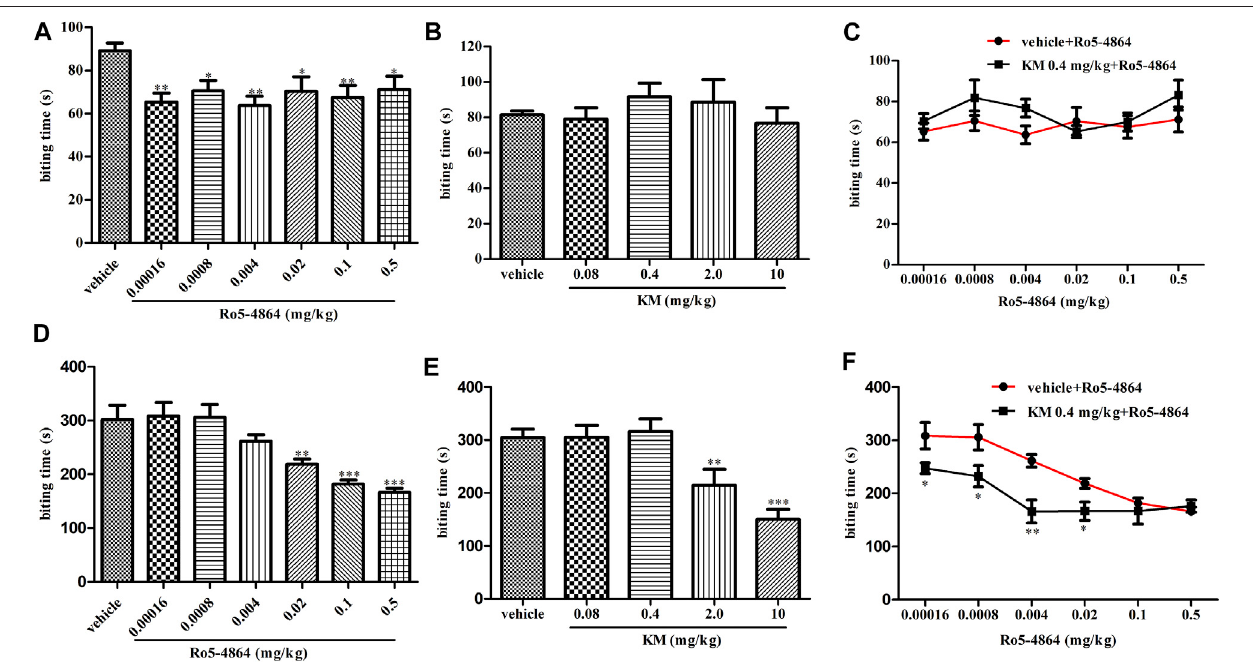
FIGURE 3| Modulation of the in vivo ef fi cacyof Ro5-4864 by koumine in the formalin test in mice. (A,B) Dose responseeffects of Ro5-4864 (A) or koumine (B) on phase Iinthe formalin test. (C) Doseresponsecurves for Ro5-4864 inthe absence orpresence of0.4 mg/kg koumine. (D,E) Dose response effectsofRo5-4864 (D) or koumine (E) on phase II in the formalin test. (F) Dose response curves for Ro5-4864 in the absence or presence of an inactive dose of koumine. Koumine (0.08 – 10 mg/kg) or vehicle was injected s. c. 40 min before formalin injection. Ro5-4864 (0.00016 – 0.5 mg/kg) or vehicle was injected s. c. 30 min before formalin injection. To determine whether koumine potentiated the anti-in fl ammatory pain effects of Ro5-4864, koumine (0.4 mg/kg, s. c.) or vehicle was injected 10 min before Ro5-4864 (0.00016 – 0.5 mg/kg, s. c.) injection. Abbreviations; KM: koumine. Data are represented as the mean ± SEM, * p < 0.05, ** p < 0.01, *** p < 0.001 vs. the corresponding vehicle group. Statistical analysis in (A,B,D,E) were performed using one-way ANOVA followed by the LSD post hoc test and in (C,F) were performed using the independent samples t -test. Each group consisted of 8 – 10 mice.